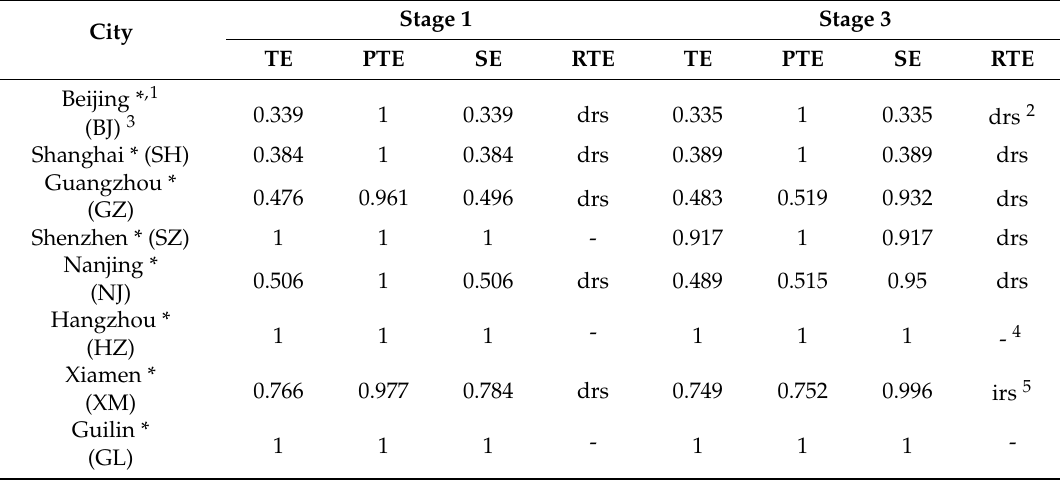
Table 5. The 33 typical cities in China before and after adjustment of municipal solid waste management (MSWM)